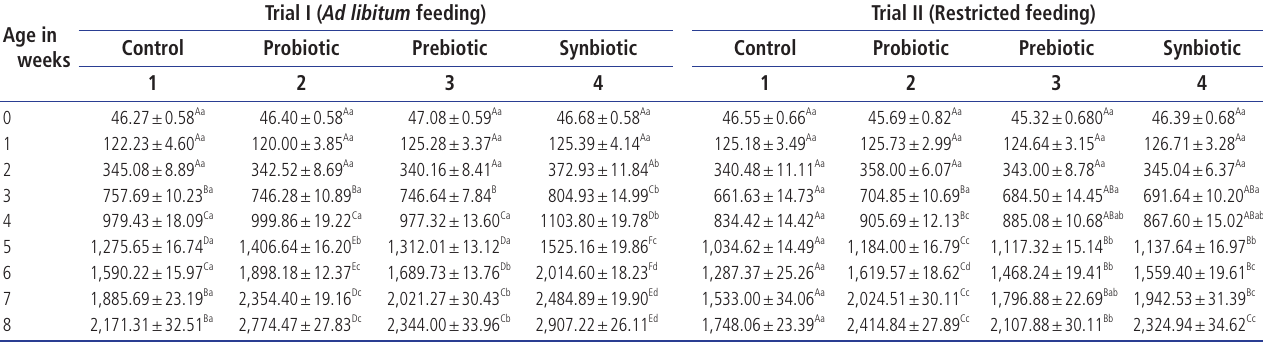
Table 2. Body weight development (in gram) of the chicks in the different experimental groups (Mean±SEM) Trial I (Ad libitum feeding) Trial II (Restricted feeding) Age in weeks